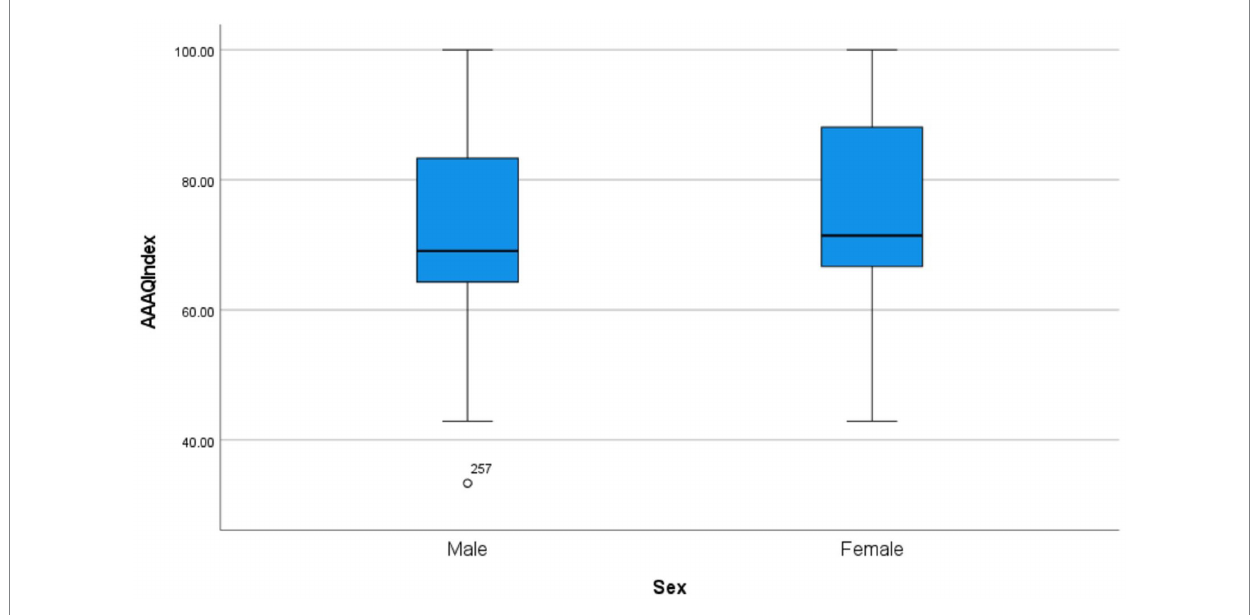
FIGURE 1 Active aging awareness scores by sex.